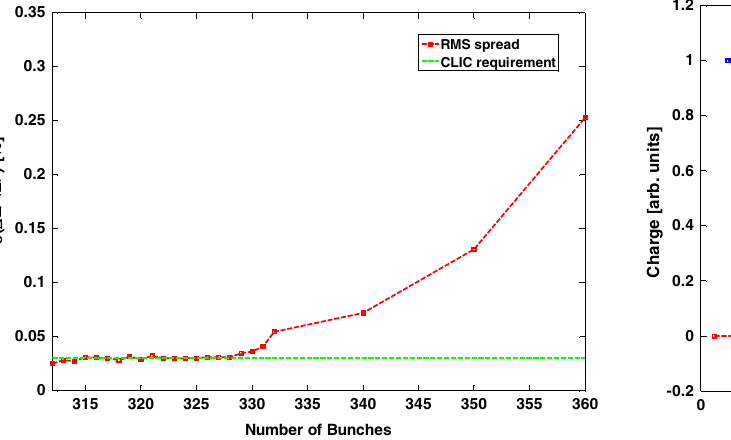
FIG. 20. Illustration of the transient in the subharmonic buncher. In this example the transient time is 8